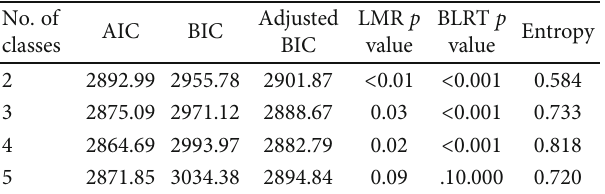
Table 2: Latent class analysis models in 297 Chilean PHC depression